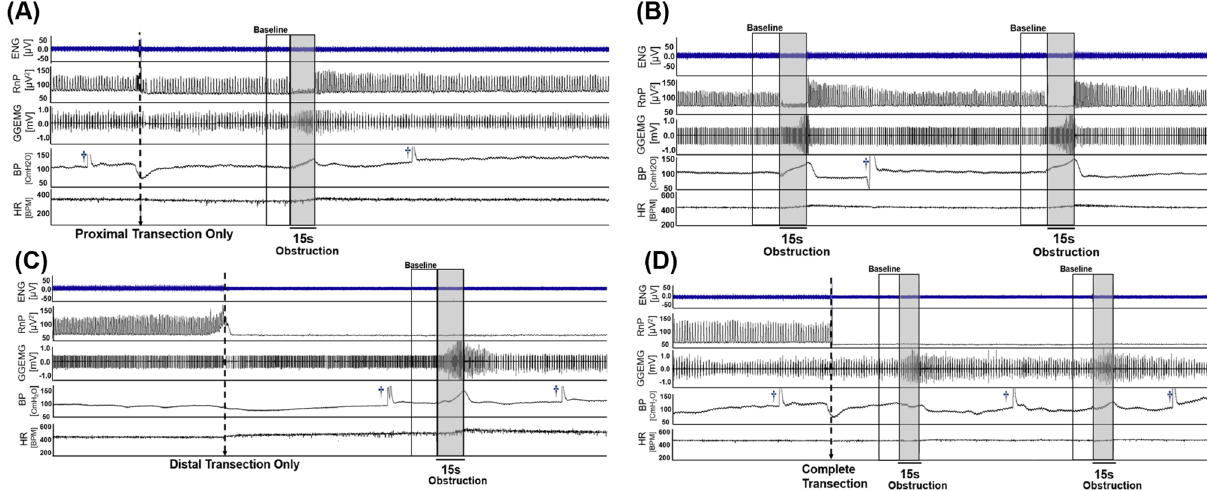
Figure 1. Sample data consisting of neural and physiological raw data that were measured when ( A ) left vagus nerve was intact, ( B ) left vagus nerve transected only at the proximal end, ( C ) left vagus nerve was transected only at the distal end, and ( D ) left vagus nerve was transected at both ends. It is noted that ( A ) and ( C ) are from the one experiment and ( B ) and ( D ) are from another experiment. Each signal trace (from top to bottom) represents the recorded neural activity (ENG: tetrapolar signal, RnP: respiratory-related vagus nerve profile) and physiological parameters (GGEMG: genioglossus muscle activity, BP: blood pressure, and HR: heart rate). Grey boxes represent upper airway obstructions. [†, denotes flushing of carotid catheter with heparinized